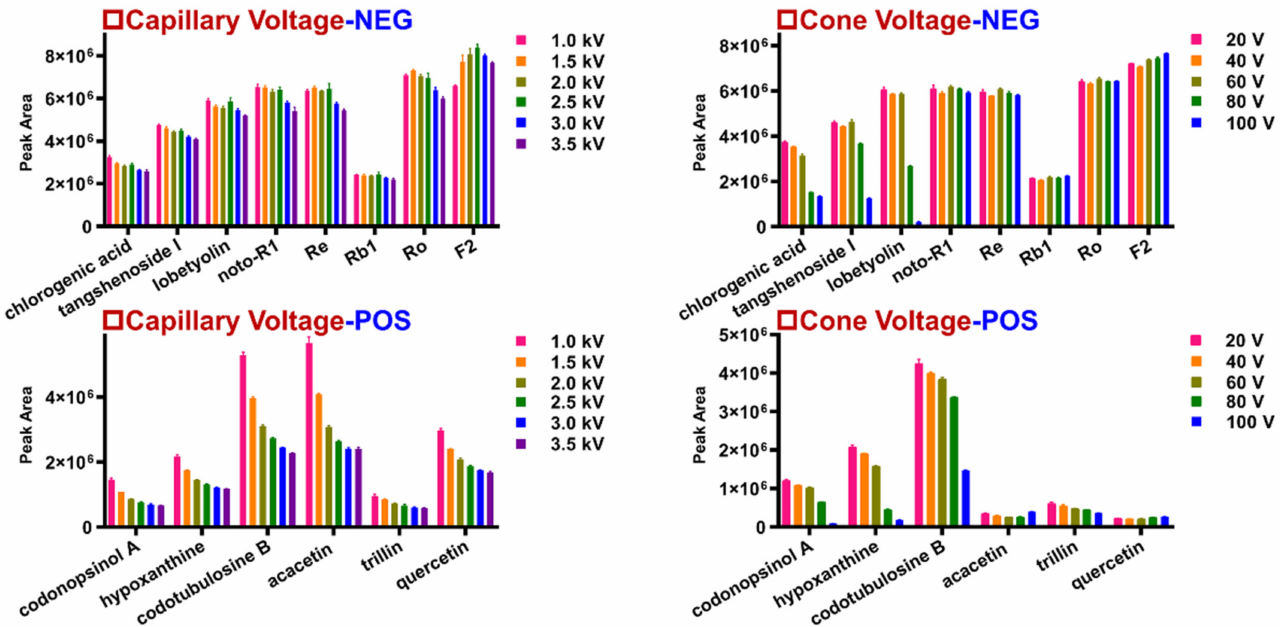
Figure 4. Optimization of the two key parameters (capillary voltage and cone voltage) in both the positive and negative ESI modes of the Vion IM-QTOF-MS system ( n =